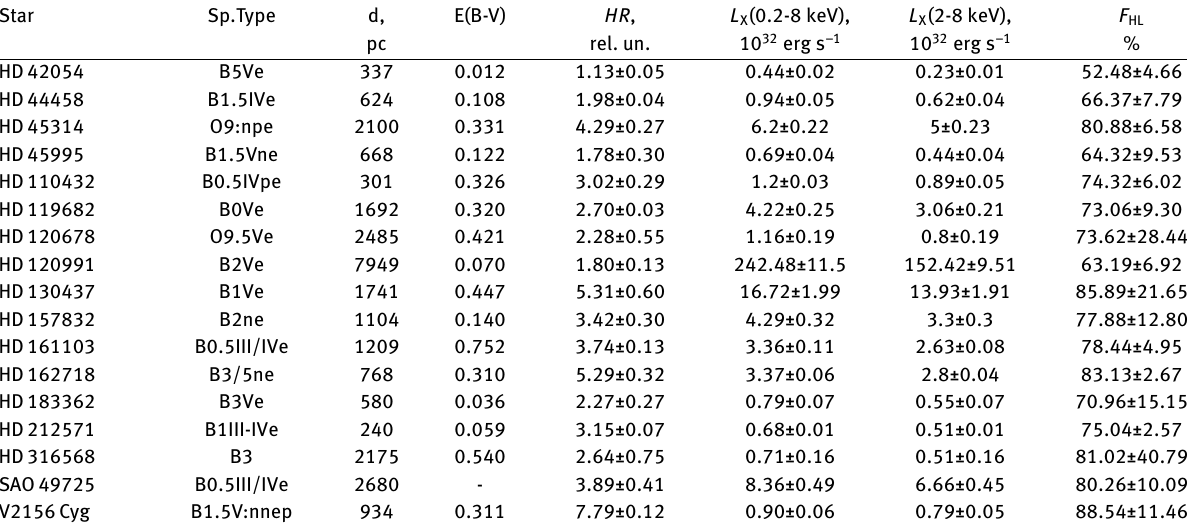
Table 2. List of targets, their parameters, and model independent characteristics of X-ray spectra.